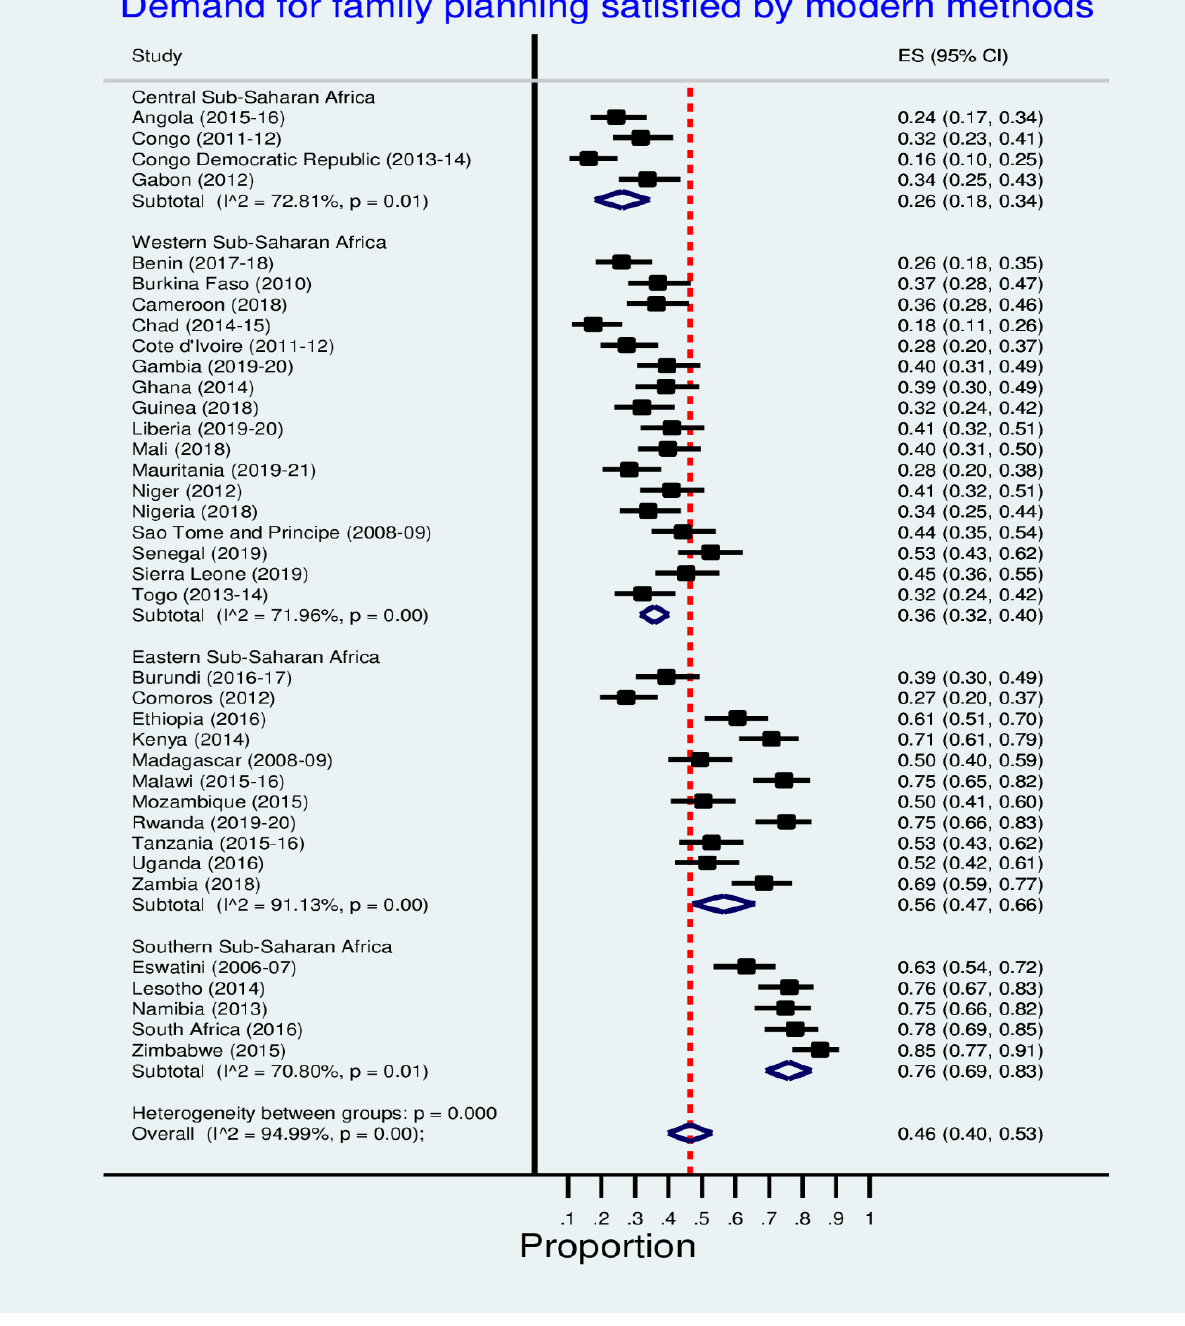
Figure 3. Prevalence of demand for family planning satisfied by modern methods.